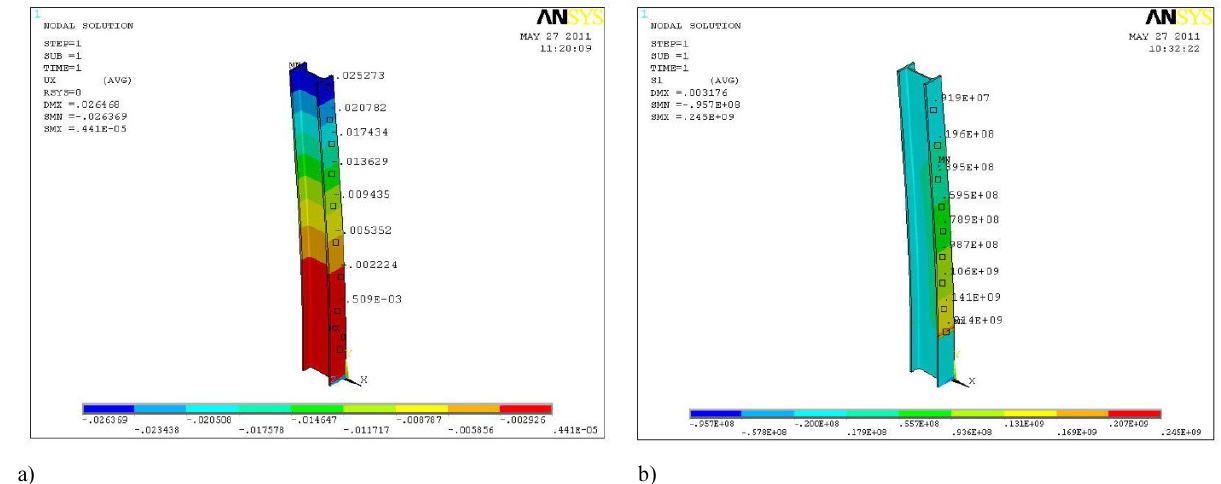
Fig. 10. The post MST-1 mounted on a bridge or a viaduct: a – deflections, b – stresses (our research)